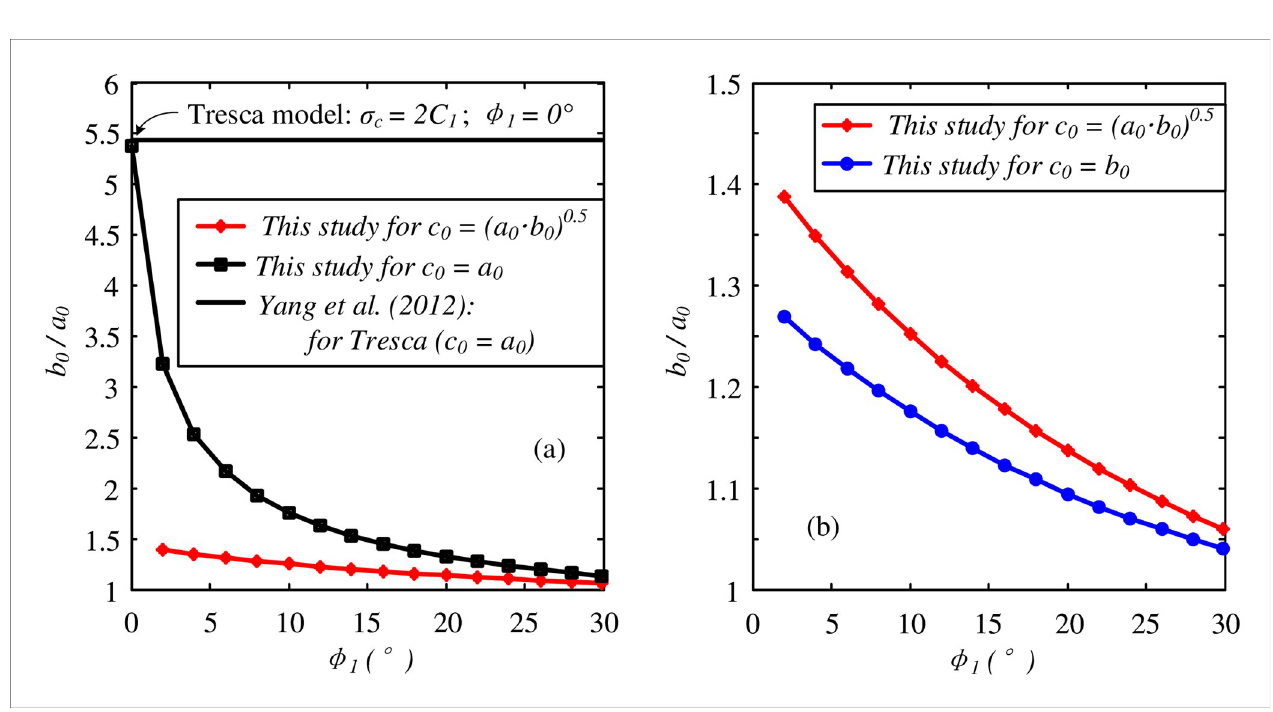
Fig 10. Comparisons with different critical conditions: (a) c 0 = a 0 ; (b) c 0 = b 0 .